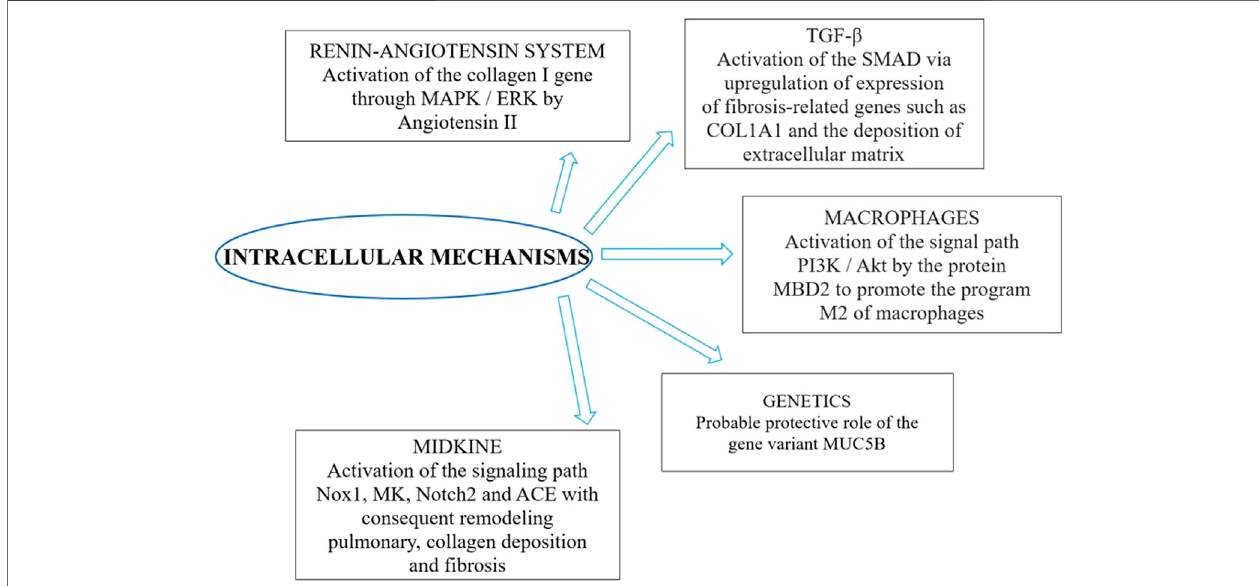
FIGURE 2 | Intracellular mechanisms involved in post COVID-19